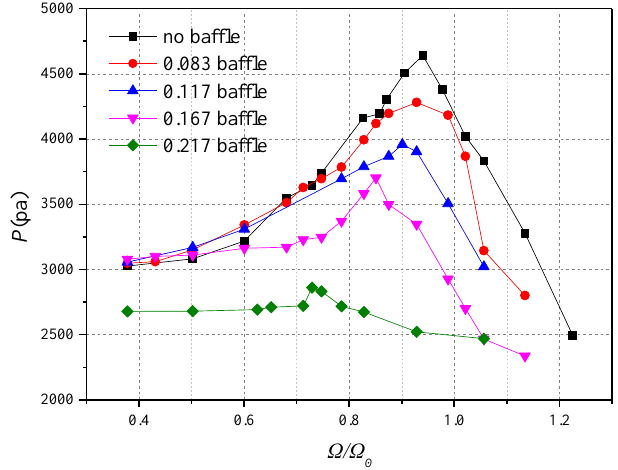
Figure 7. Comparisons of impact pressure under different heights of the vertical baffle.